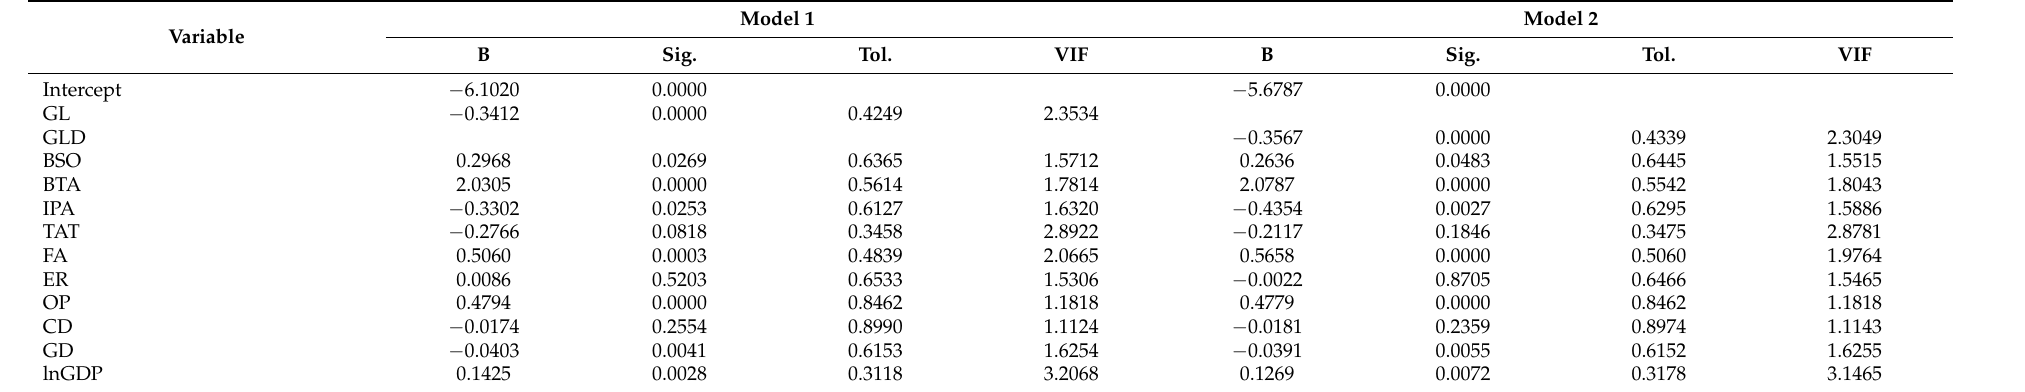
Table 4. Determinants of International Market Selection: Binary Logistic Test ( n = 4320, entry = 843, no entry =